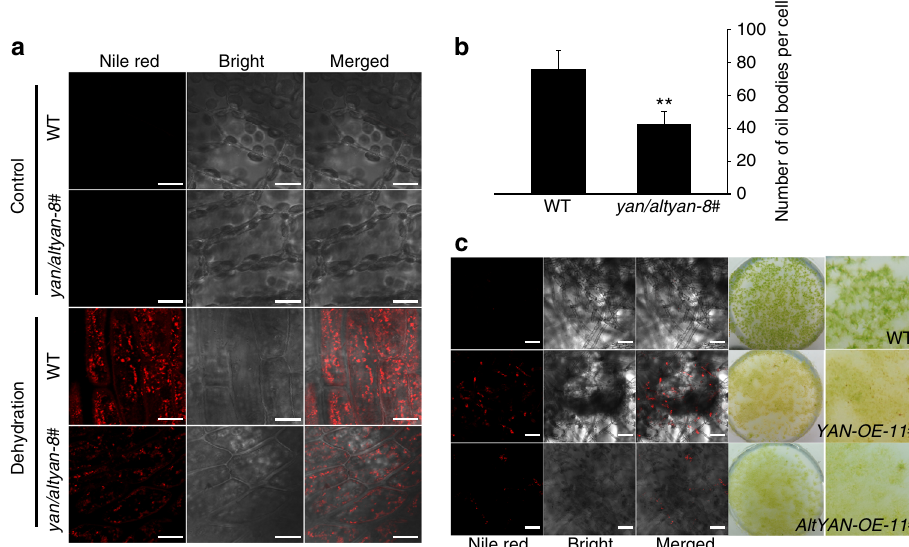
Fig. 4 In situ oil bodies and their quanti fi cation. a Accumulation of oil bodies in wild-type plants and yan/altyan mutants. Four-week old plants were dehydrated for 30 min, and plants under normal growth conditions were used as control. Plants were stained with Nile red dye (25 μ g ml − 1 methanol) for 12 h before observation. Scale bar = 20 μ m. b Quanti fi cation of oil bodies in wild-type plants and yan/altyan mutants under dehydration treatments. Results represent means and standard deviations of three biological replicates for the wild-type and yan/altyan-8# . Double asterisks indicate a statistically signi fi cant difference compared with wild-type plants based on a two-tailed Student ’ s t test ( p < 0.01). c YAN-OE and AltYAN-OE plants accumulated excessive oil bodies under normal conditions and showed delayed growth. Two-week old wild-type as well as YAN-OE and AltYAN-OE plants were used to observe oil bodies. Scale bar = 0.2